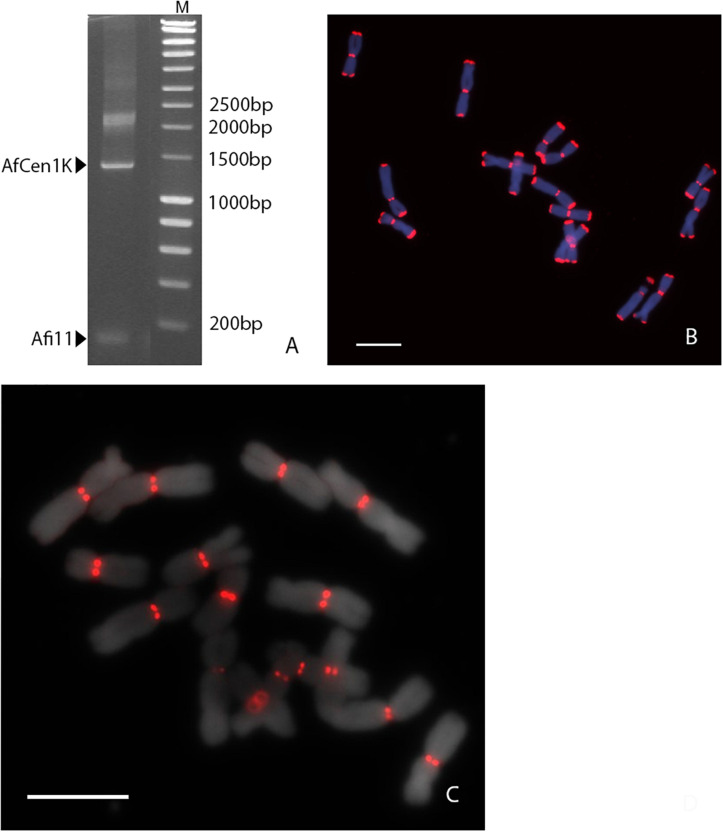
Identification of full-length A. fistulosum centromere repeat sequence. (A). Long-range PCR amplification with Afi11 (CENH3-associated fragment) primers on genomic DNA of A. fistulosum. PCR products corresponding to original Afi11 fragment (158 bp) and full-length centromeric repeat (AfCen1K, <1,249 bp) are indicated (M – GeneRulerTM 1 Kb DNA Ladder). FISH on A. fistulosum mitotic metaphase chromosomes with the labeled PCR product from long-range PCR amplification with Afi11 primers (B) and with an individual plasmid carrying the full-length AfCen1K (bar = 10 μm) (C).